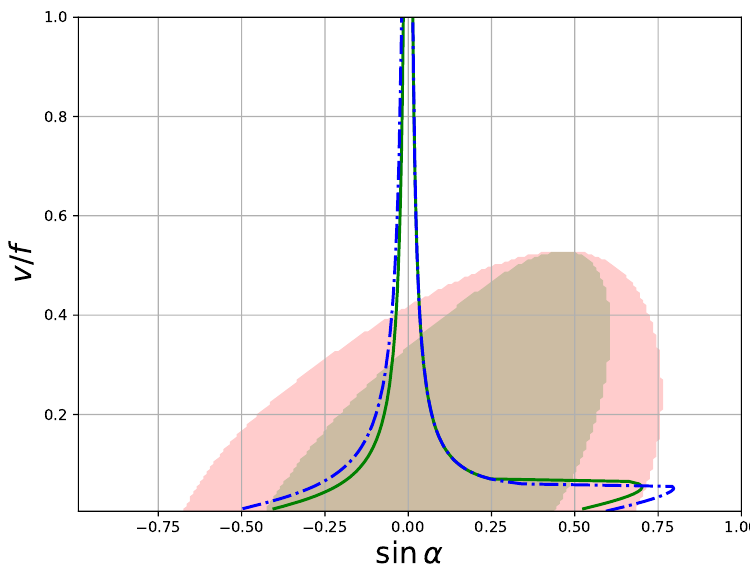
Figure 1 . Constraints on the mixing angle between the Higgs and dilaton against the ratio v=f , computed using Lilith (solid green contour) and HiggsSignals (blue dot-dashed contour). We also show the allowed regions from constraints originating from the electroweak S and T parameters for dilaton masses of 3000 GeV (inner, light brown shaded region) and 500 GeV (outer, light red shaded